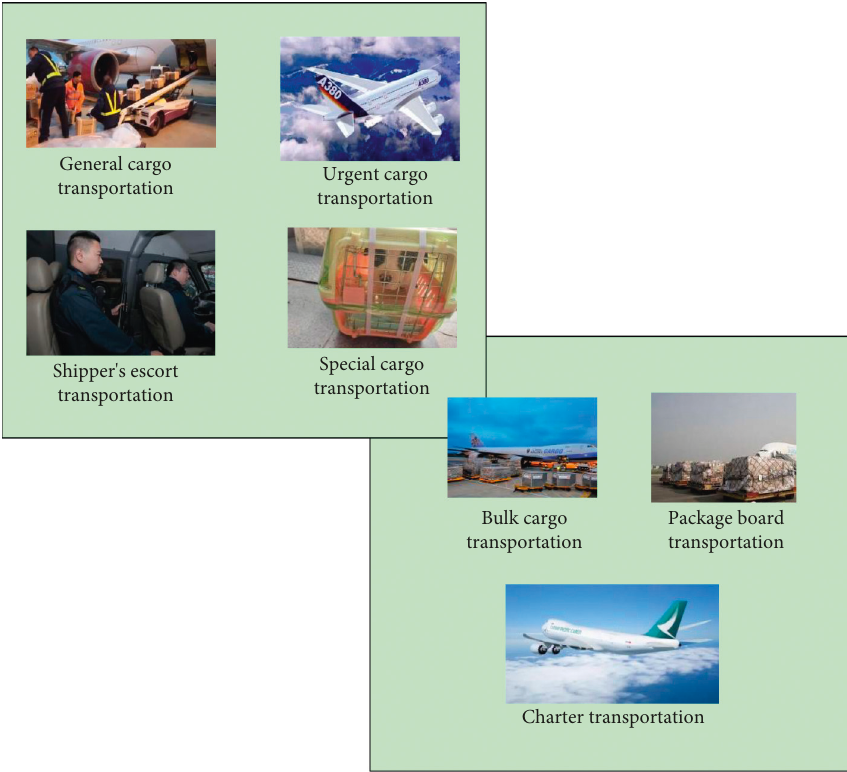
Figure 4: Common types of air cargo transportation. Table 2: Experimental data table of vegetable preservation based on vacuum precooling preservation technology.